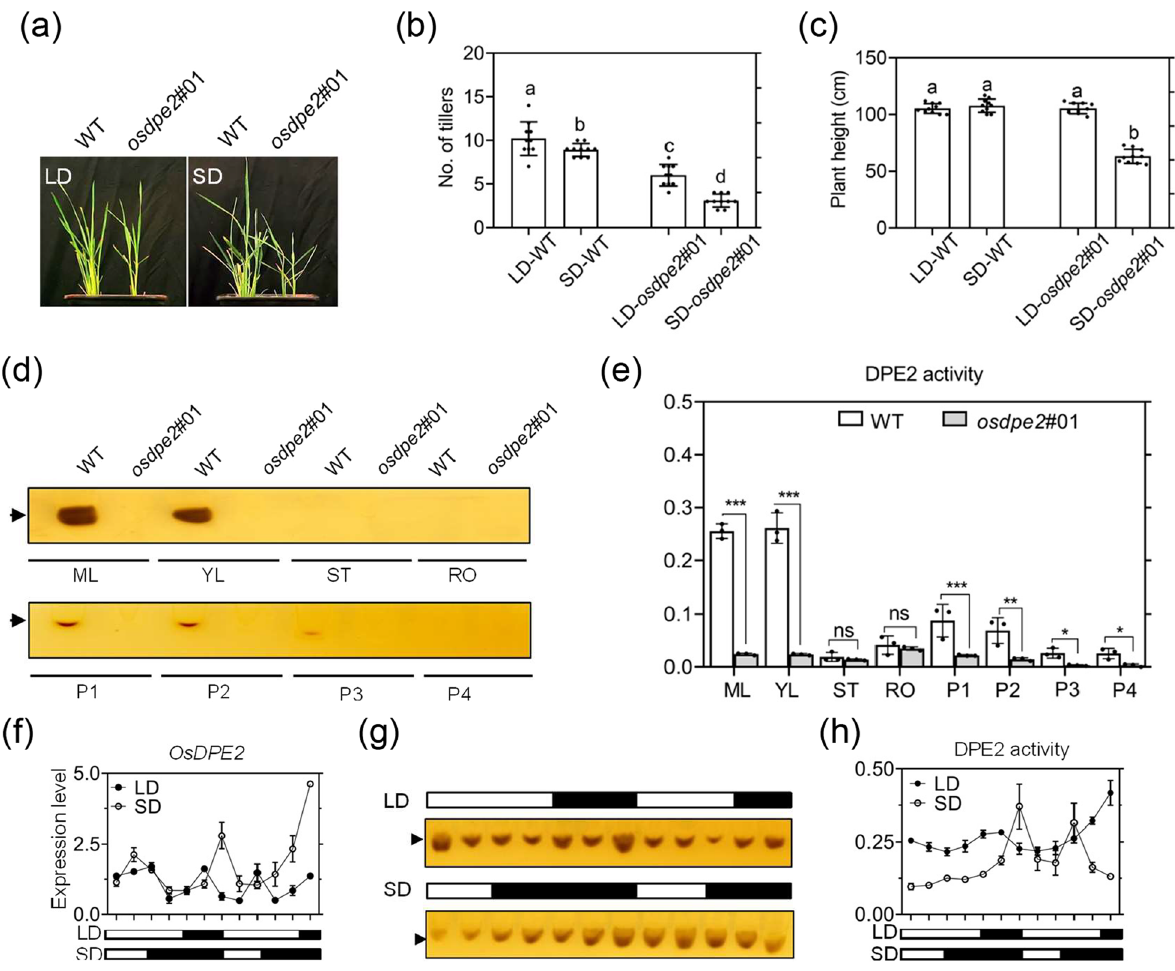
Fig. 3 OsDPE2 affects vegetative plant development of rice via DPE2 enzyme activity, and DPE2 enzyme activity fluctuates rhythmically due to diurnal alternations. a – c Growth rate analysis of the plants under long day (LD, 16 h light/8 h dark) and short day (SD, 8 light/16 dark) conditions. a Images of wild-type and osdpe2#01 seedlings under LD and SD. Number of tillers ( b ) and plant height ( c ) of wild-type and osdpe2#01 seedlings under LD and SD conditions. Data are expressed as mean SD (n 10 biologically independent samples). Bars represent mean standard ± = ± deviation; Tukey’s multiple comparisons test. Different letters represent statistically significant differences between data groups. d DPE2 enzyme activity and e OD values in ML, YL, ST, RO, P1, P2, P3, and P4. Three samples of ML, YL, ST and RO were mixed to form a biological replicate, and each data group contained three biological replicates. One biological replicate contained ten young panicle tissues. Bars represent mean SE (one-way ± ANOVA). f The 48-h rhythmic OsDPE2 expression analysis of the WT plants under LD and SD conditions. g The 48-h rhythmic in-gel DPE2 enzyme activity assay and h OD values of the DPE2 enzyme activity assay of WT under LD and SD conditions. The arrow indicates DPE2 enzyme